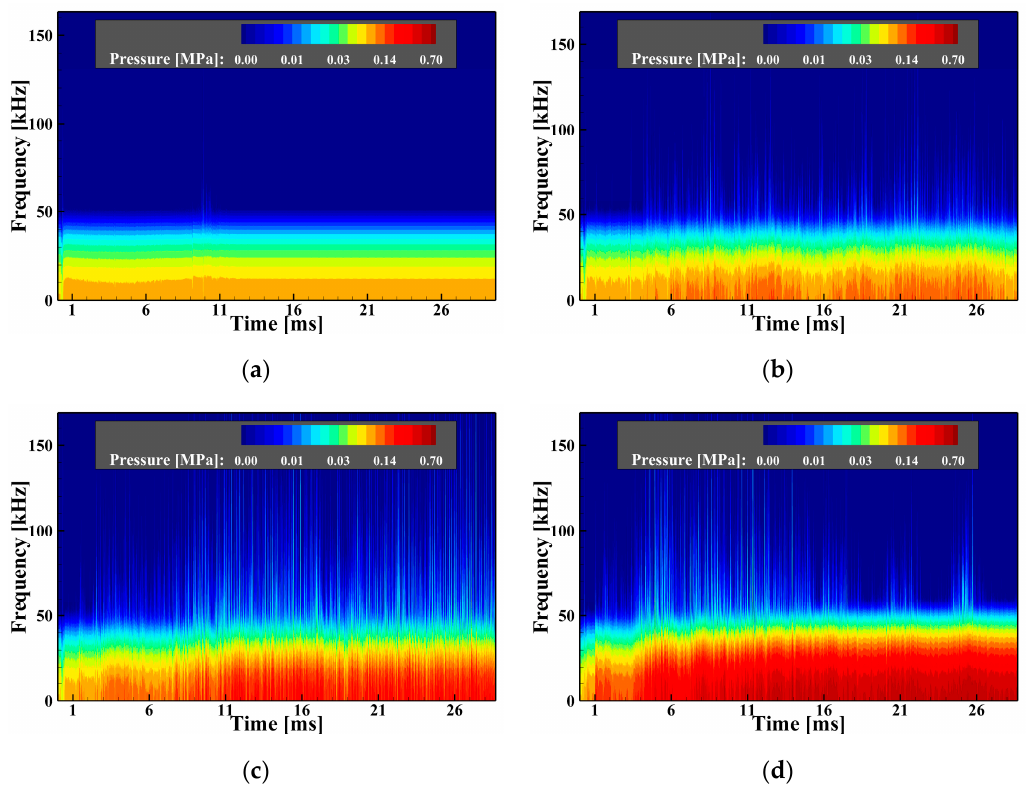
Figure 6. The STFT results for the pressure history of each case: ( a ) 0.75 MPa, nozzle-type, w/o cavity; ( b ) 0.75 MPa, nozzle-type, w/cavity; ( c ) 1.0 MPa, nozzle-type, w/cavity; ( d ) 0.75 MPa, straight-channel-type, w/o cavity.